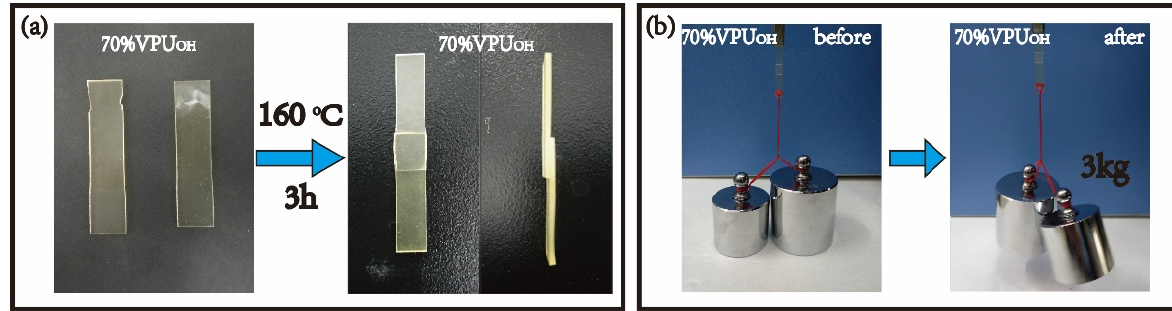
Figure 7. ( a ) Optical images, before and after welding, of 70%VPU OH , ( b ) Optical images of the welding performance of 70%VPU OH .